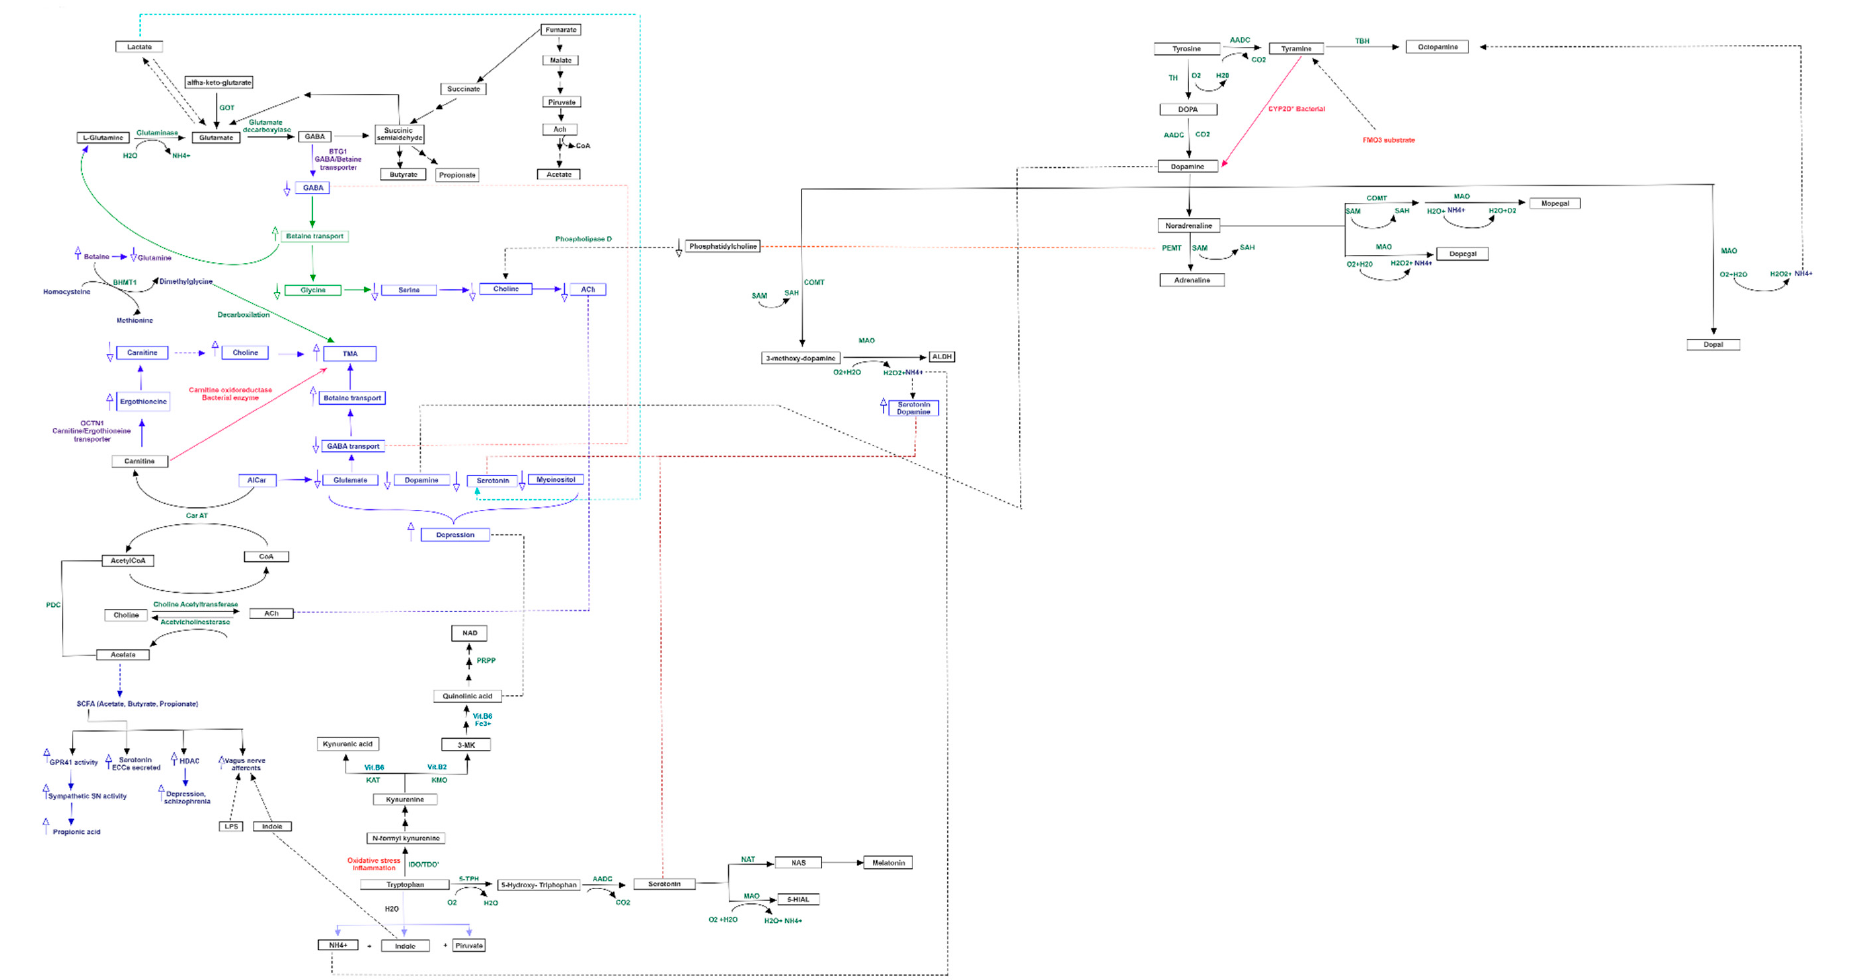
Figure 6. Detailed diagram of biochemical pathways linking neurotransmitter and TMA metabolisms. The figure represents how neurotransmitter and TMA pathways might be correlated. Dashed lines represent indirect and candidate relationships. Empty arrows indicate over- or -down-expression of adjacent metabolite